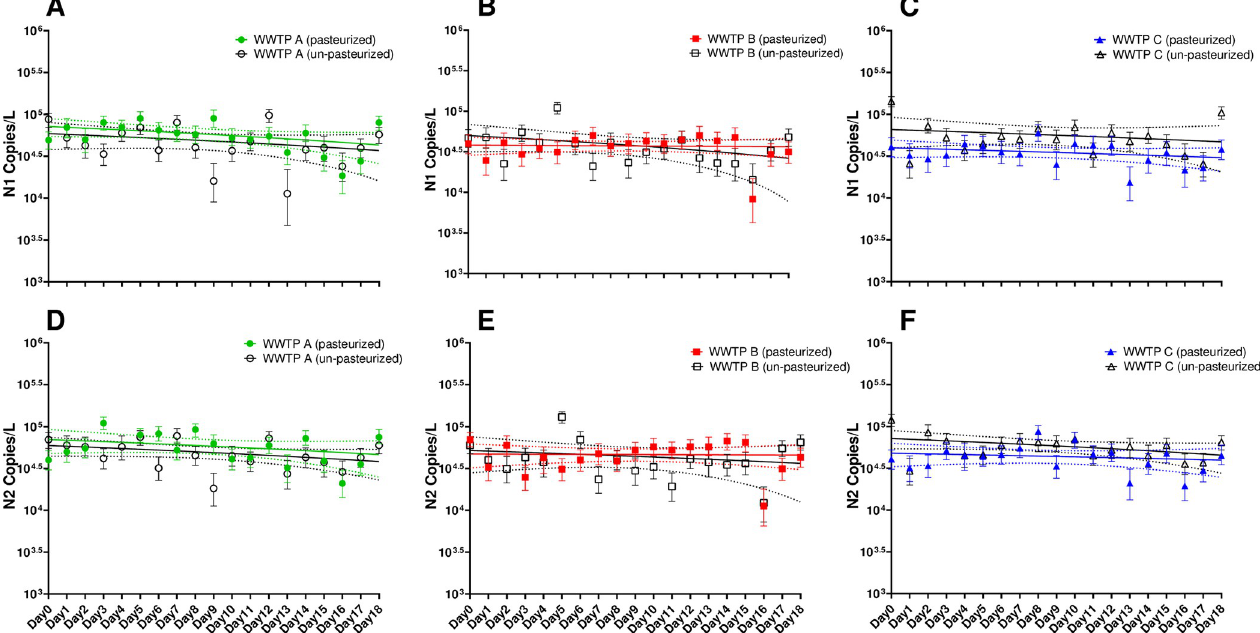
Fig 2. Concentration of SARS-CoV-2 N1 (A-C) and N2 (D-F) genes represented as copies/L in heat pasteurized and unpasteurized samples at three WWTP. Samples are represented by the mean concentration of a minimum of 20,000 droplets per sample +/- the upper and lower 95% confidence interval. Linear regressions of copies/L over the 19-day experiment in heat pasteurized and unpasteurized samples are represented by solid lines with the 95% confidence interval of the slope represented as dashed lines.